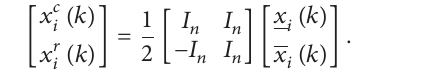
Figure 6: Trajectories of the first element of the state.